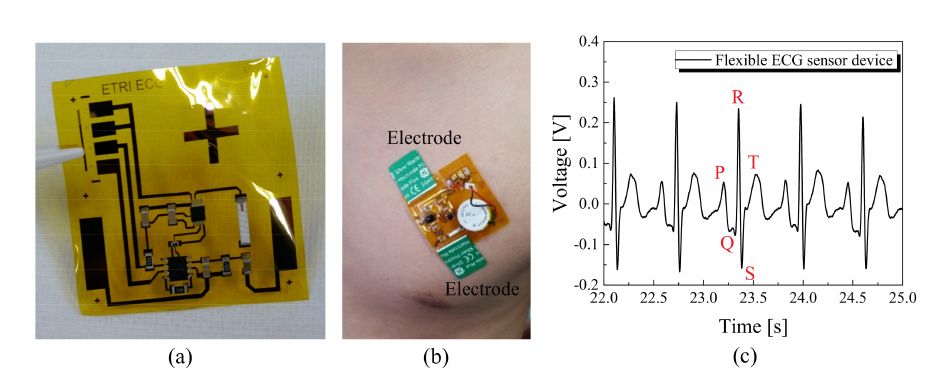
Figure 5. Images of the flexible sensor device and its operation as an electrocardiogram (ECG) sensor: ( a ) the flexible ECG sensor device detached from the PDMS layer/glass substrate; ( b ) the flexible sensor device attached to curved skin surface of chest; ( c ) ECG signals measured by the flexible sensor